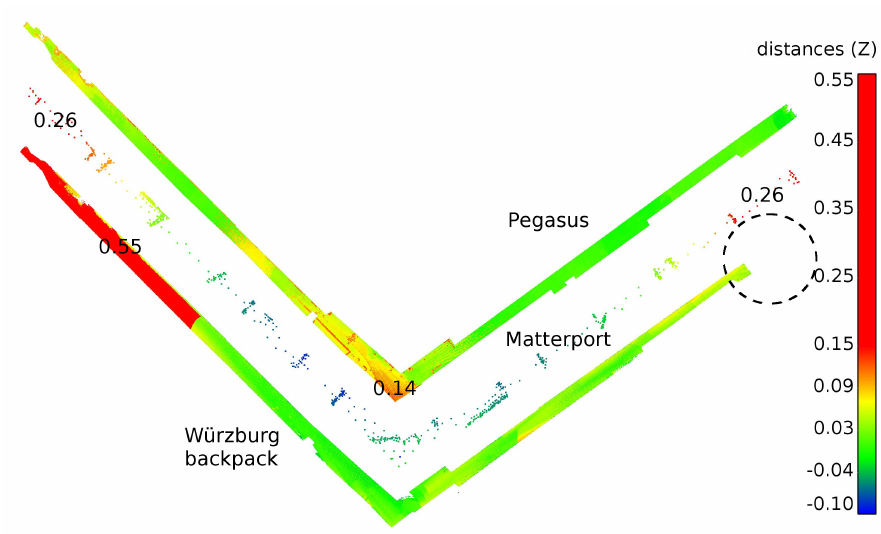
Figure 21. Floor elevation deviations from the reference with the color scale from − 0.10 m–0.15 m. Deviations over 0.15 m are shown in red. Note that the color scale is different than in the previous figure due to a different level of Z variation of the results. The dotted circle displays the location of some missing data. Numbers on the plot indicate maximum deviations in